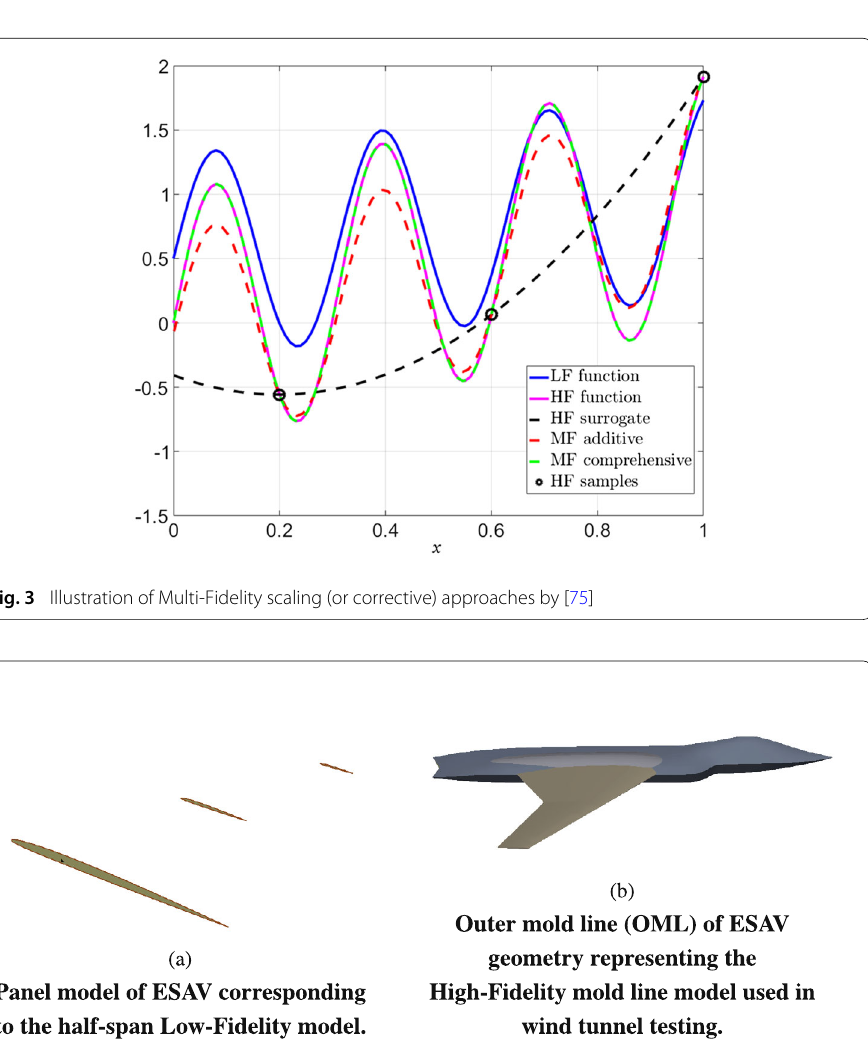
Fig. 4 Baseline of an efficient supersonic air vehicle (ESAV) model